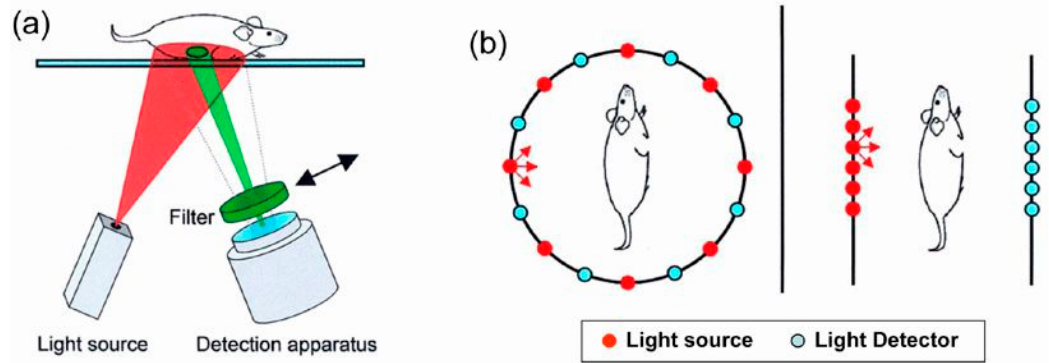
Figure 11. ( a ) Schematic of an epi-luminescence 2D-fluorescence reflectance imaging system that is commonly used for macroscopic fluorescence imaging applications but suffers from poor resolution and nonlinear signal attenuation in deep tissues. ( b ) Schematic of FMT systems using ring or planar geometry. Multiple source (red dots) and detector (blue dots) projections are made through the animal, and the fluorescence distribution is calculated by back-projecting physical models of light propagation through tissue. Reprinted from [100]